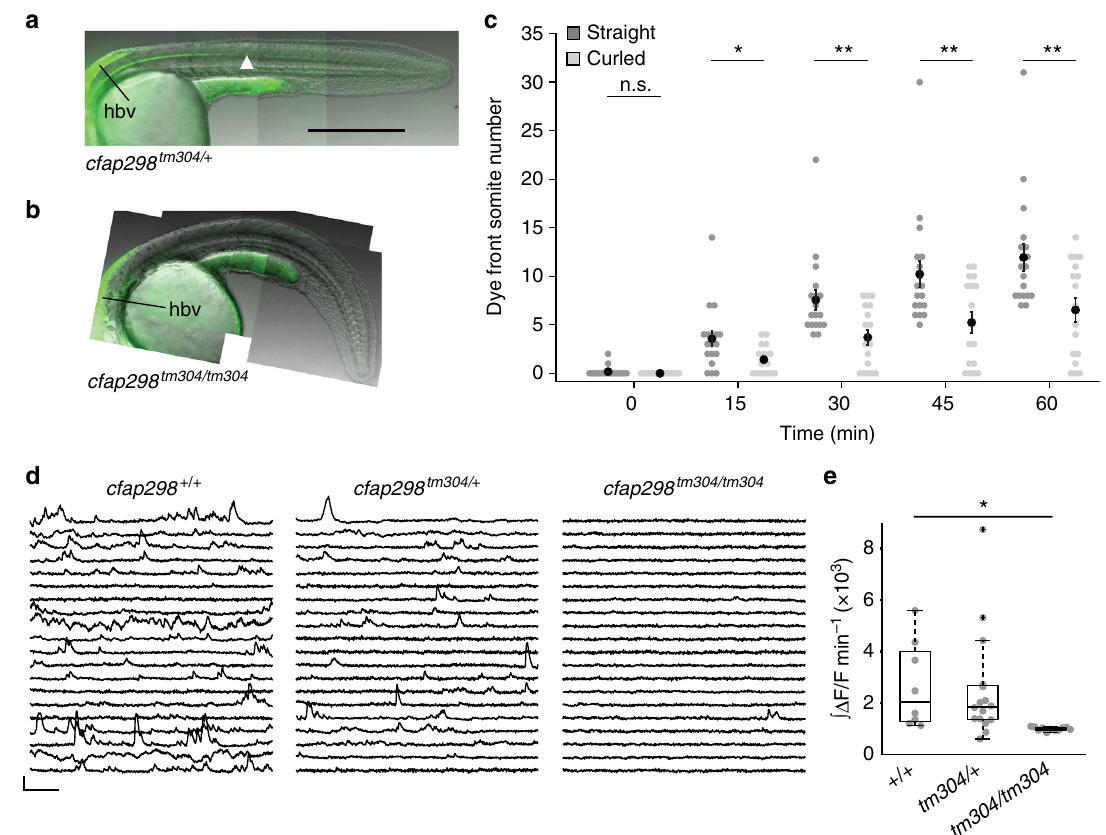
Fig. 2 c fap298 is required for CSF transport down the rostrocaudal axis and activity of sensory CSF-contacting neurons. Representative images of 28 hpf a cfap298 + / + and b cfap298 tm304/tm304 embryos 60 min after injection of fl uorescent beads into the hindbrain ventricle (labeled by the black line), the bead front is indicated by an arrowhead in a . Scale: 250 µ m. c Quanti fi cation of dye front experiments. ( n = 18 straight cfap298 + / + and cfap298 tm304/ + embryos, n = 17 curled cfap298 tm304/tm304 embryos). Each point represents one embryo. Error bars represent s.e.m, * p < 0.05, ** p < 0.01. d Sample